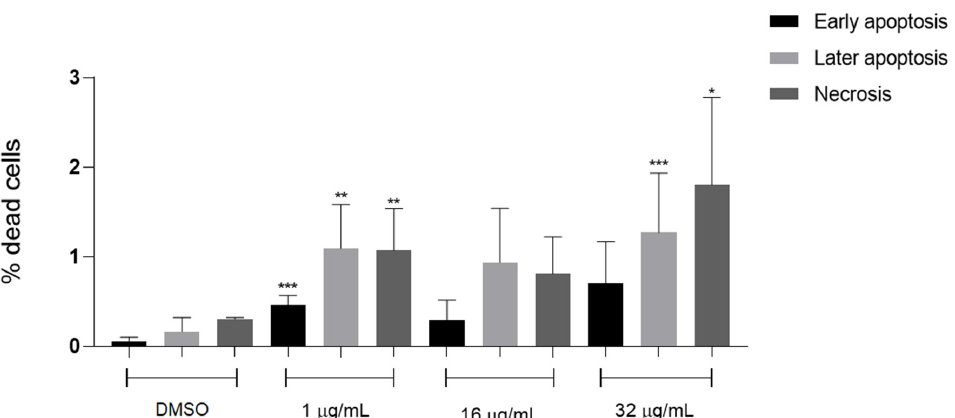
Figure 1. Effect of ACW-02 on J774 macrophages through the annexin V-FITC/PI method after 2 h. Asterisks represent statistically differences between treated and untreated macrophages; * p < 0.05; ** p < 0.01; *** p < 0.001. ANOVA followed by Tukey’s multiple comparisons test. As demonstrated, in the absence of the compound, all cells were viable as the per- centage of initial, late apoptosis and necrosis was 0%. In contrast, in a concentration of 1 µg mL − 1 , the percentage of cells in initial, late apoptosis and necrosis was 0.46, 1.09 and 1.07, respectively. When increased to the concentration of 16 µg mL − 1 , there is a decrease in the percentages, these being 0.29, 0.94 and 0.81, respectively. Finally, at a concentration of 32 µg mL − 1 , the percentages increase to 0.70, 1.27 and 1.8, respectively. In comparison to negative control, which has shown values of 0.06, 0.17 and 0.31%, ACW-02 exhibits approximate values, highlighting its viability as non-cytotoxic to macrophages.